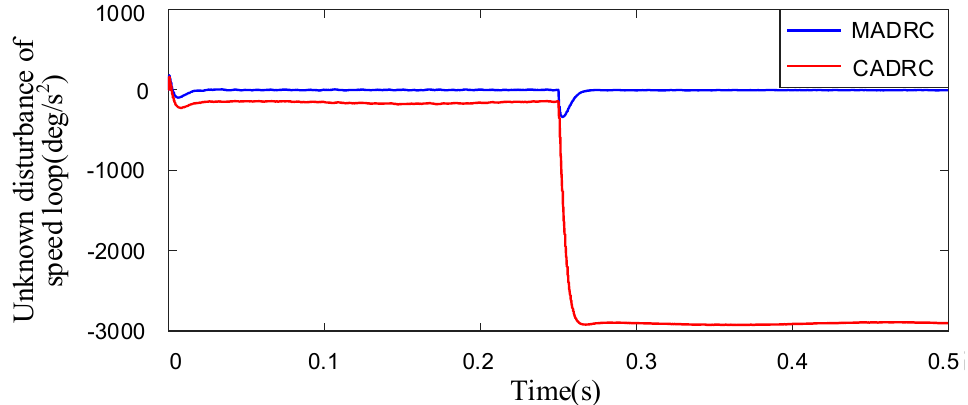
Figure 7. CADRC, MADRC, and PI response curves.